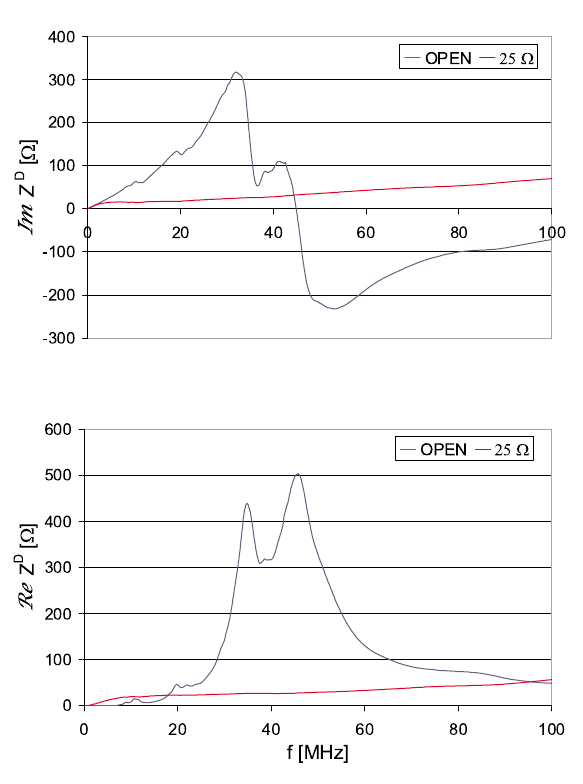
FIG. 22. (Color) Input impedance of K1 at